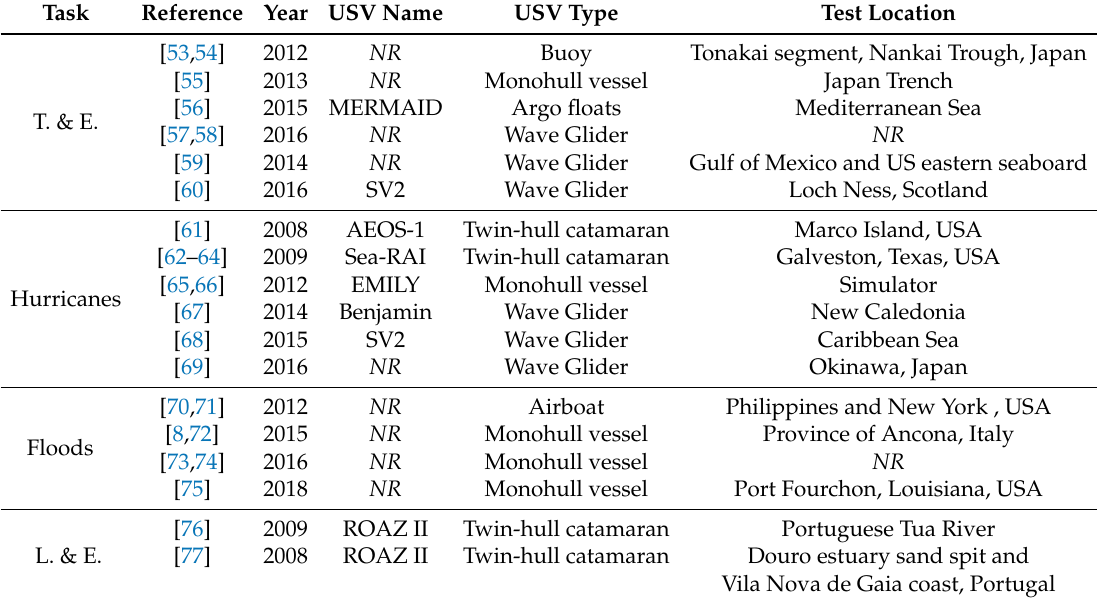
Table 2. Characteristics of work related to natural disasters grouped by task, where “T. & E.” stands for “Tsunami & Earthquake”, “L & E” stands for “Landslides & Erosion”, and “NR” stands for “Not